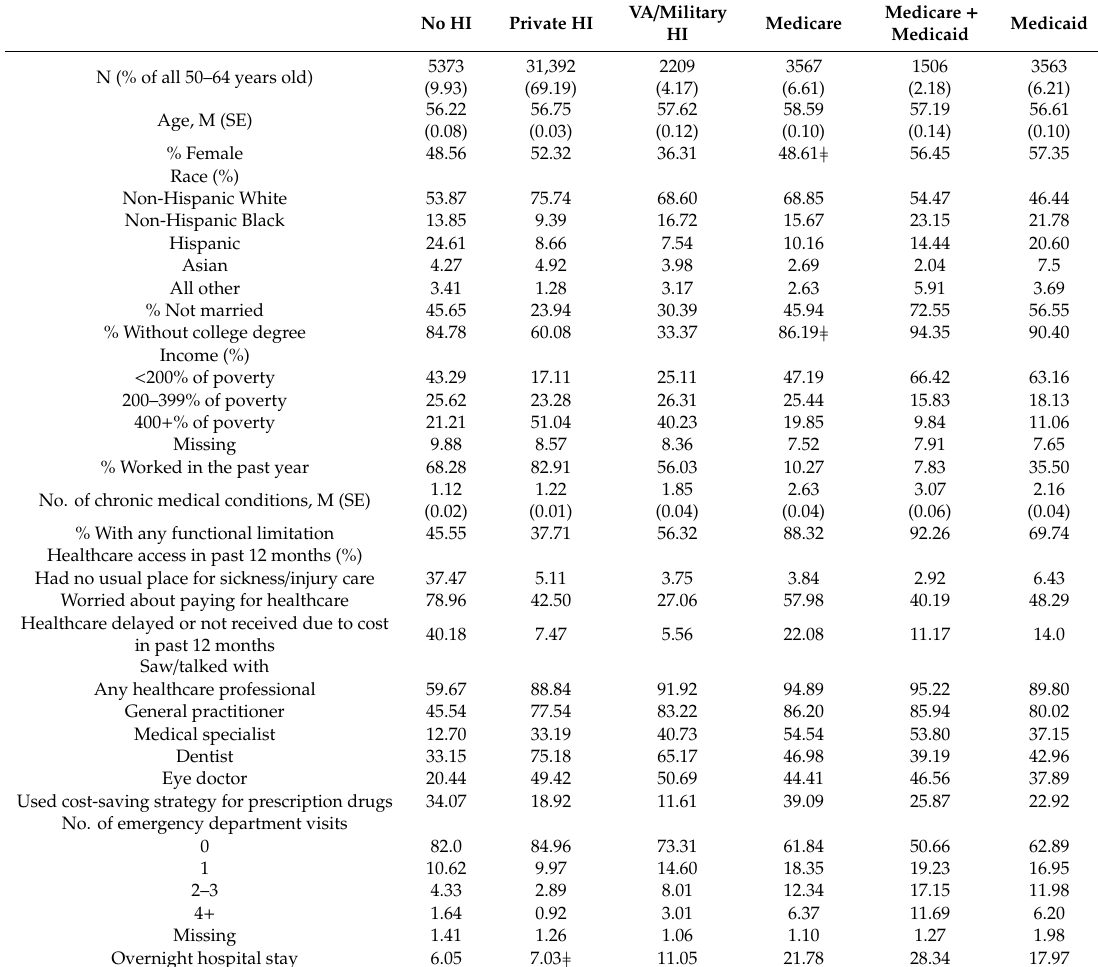
Table 3. Comparison of those without any health insurance (HI) to those with di ff erent types of HI among the 50–64 age